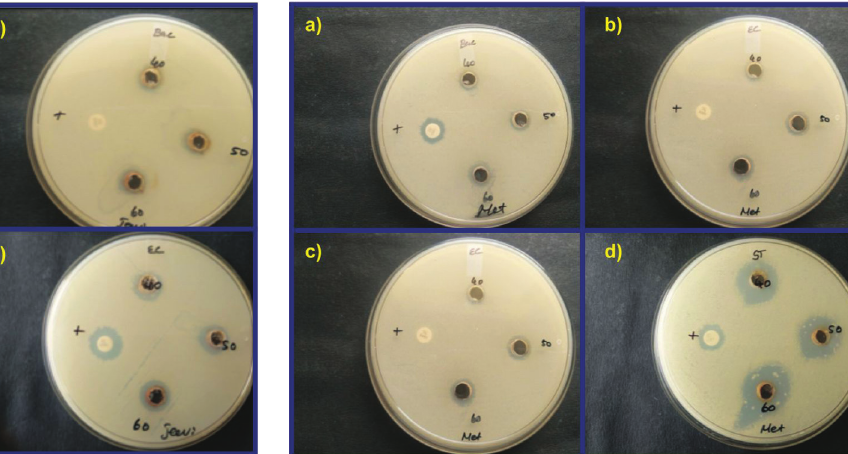
Figure 11: Antibacterial activity of A. bilimbi leaf extract mediated synthesized AgNPs: (a) Escherichia coli , (b) Staphylococcus aureus , (c) Pseudomonas aeruginosa and (d) Salmonella typhi .